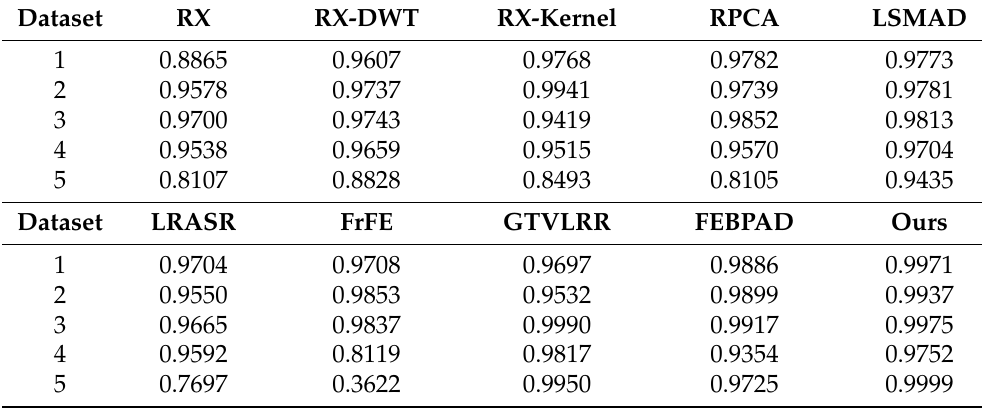
Table 2. AUC values of the proposed method and state-of-the-art methods on three HSI datasets.